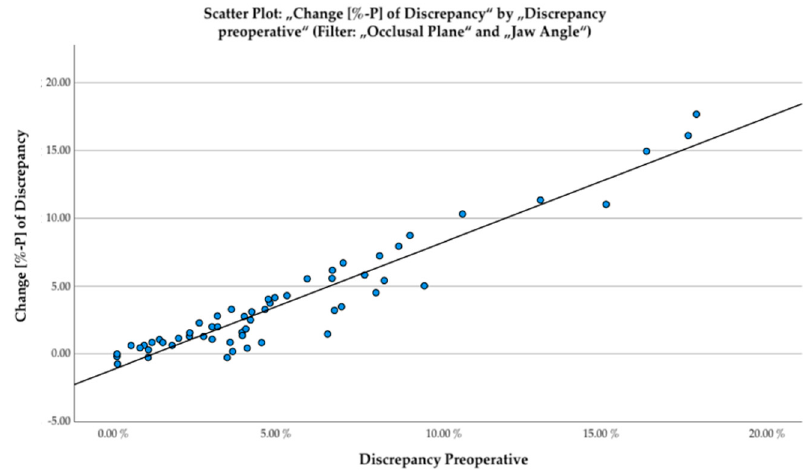
Figure 13. Scatter plot displaying reduction of discrepancy in percentage points (change of discrep- ancy) vs. amount of preoperative asymmetry (discrepancy pre-op).